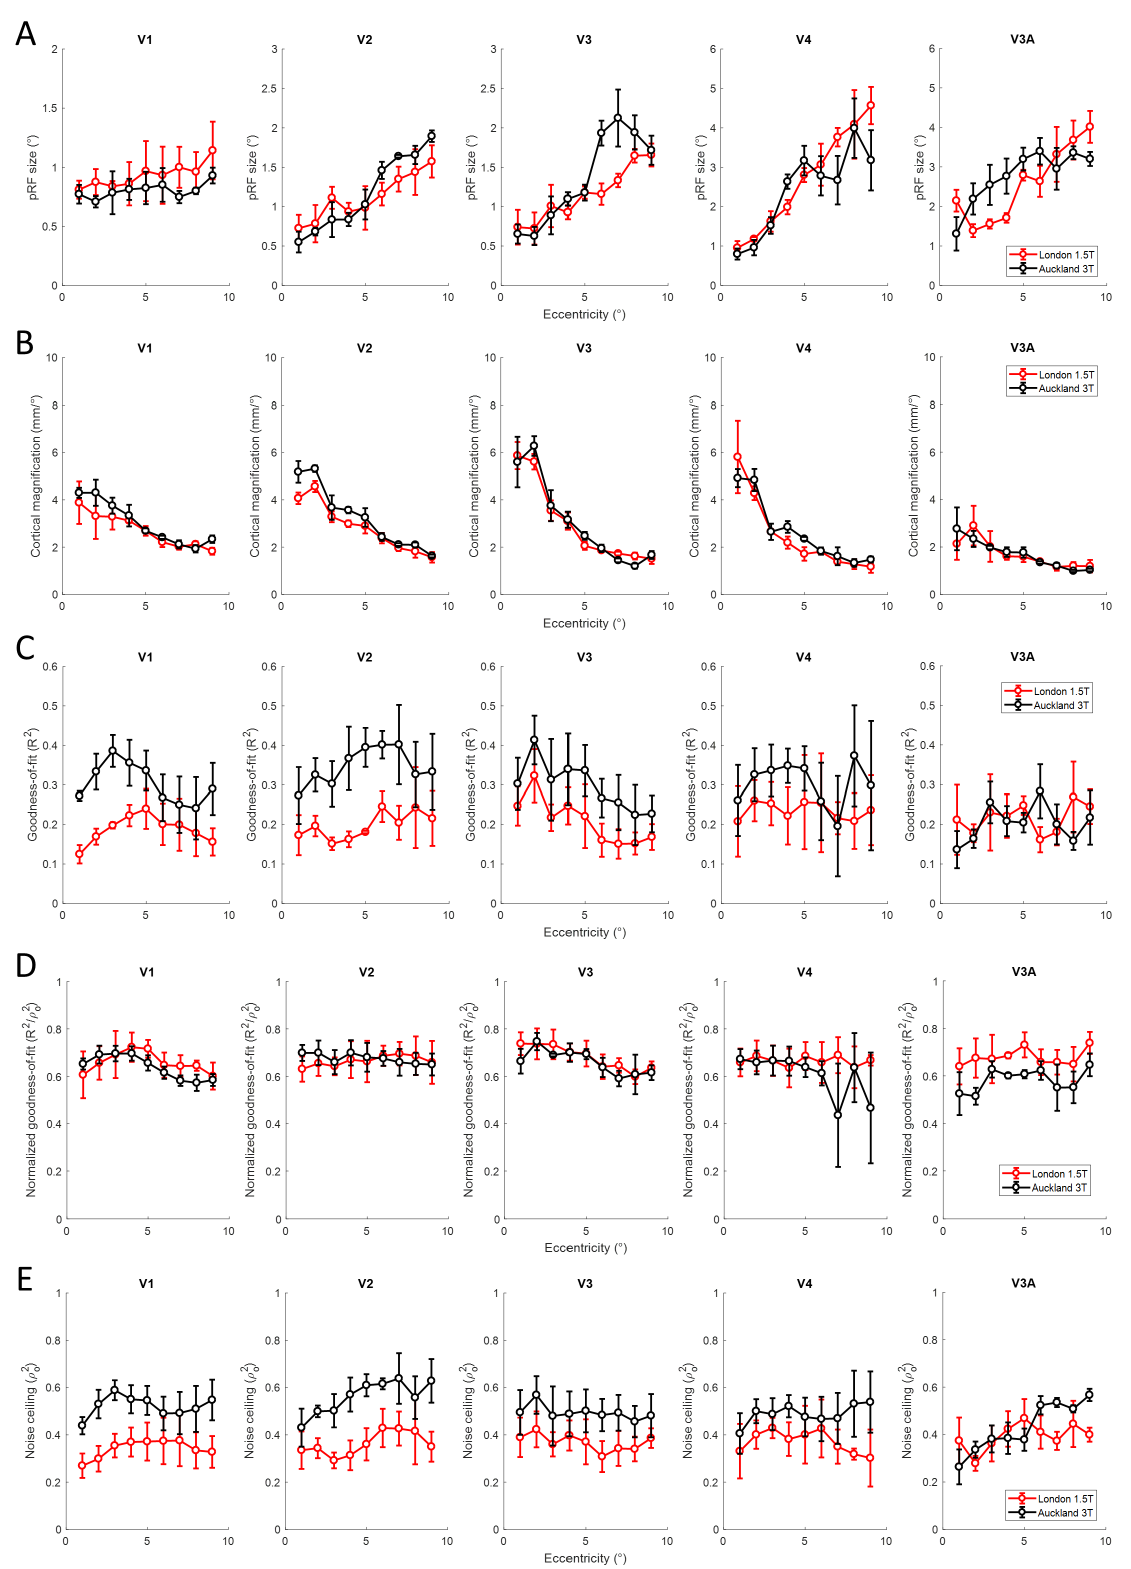
Figure 3. Mean population receptive field (pRF) size ( A ) and median cortical magnification factor CMF ( B ), median goodness-of-fit ( C ), normalized goodness-of-fit ( D ), and noise ceiling ( E ) binned into eccentricity bands for the London 1.5T site (red) and the Auckland 3T site (black) and averaged across the three participants. Columns show different visual regions. Error bars denote ±1 standard error of the mean across participants.